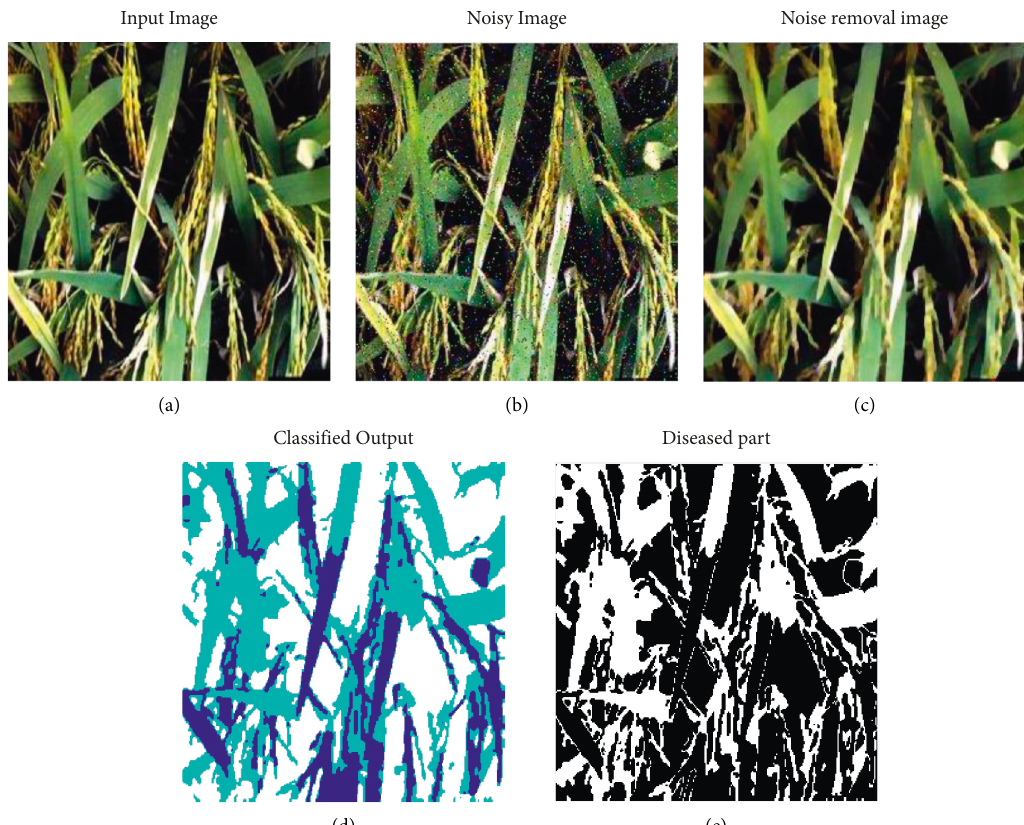
Figure 14: Region of interest separated from segmentation using FCM. (a) Input image of bacterial leaf blight. (b) Noised image. (c) After noise removal. (d) Colour-based using FCM. (e) Segmented greyscale image.